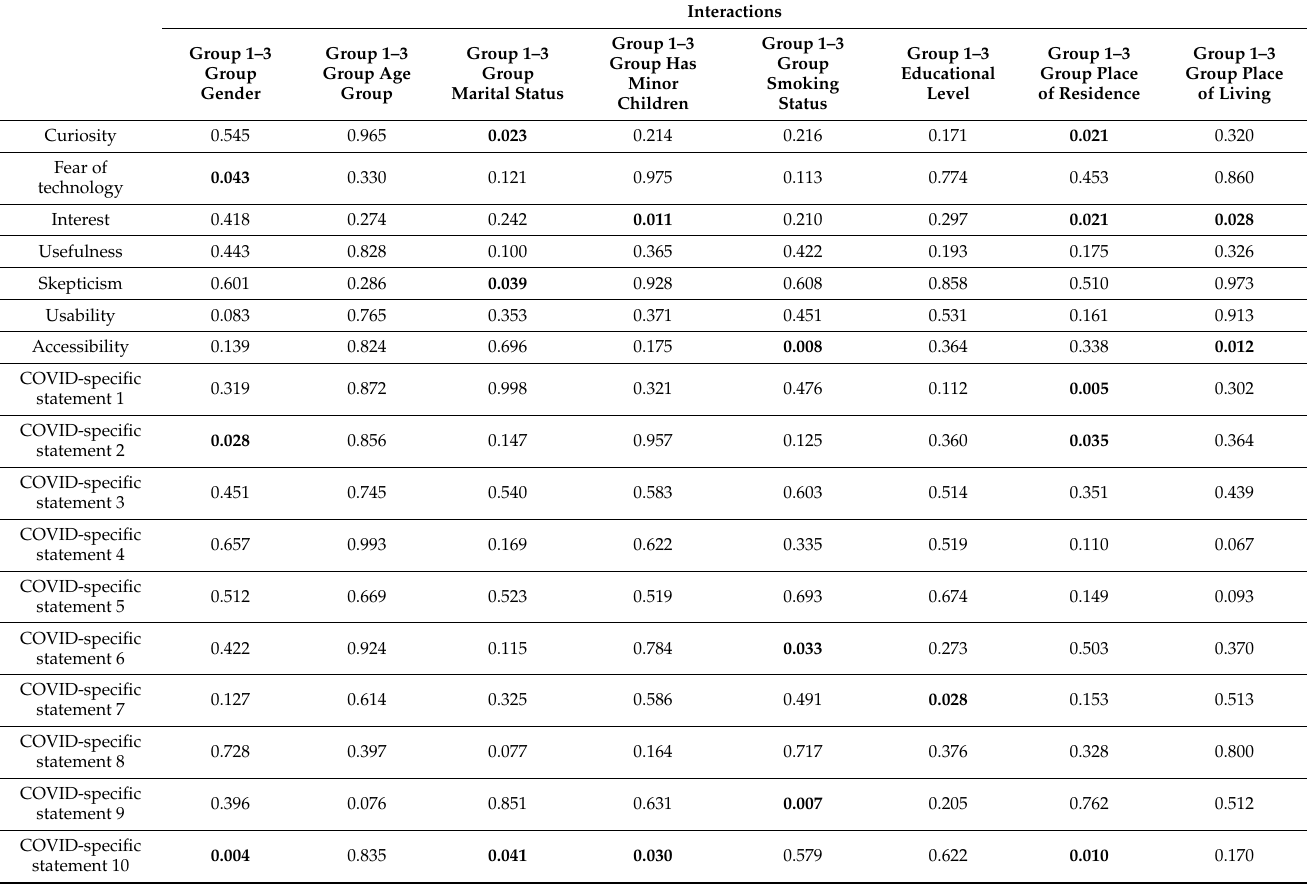
Table A1. p -values of interactions between Group 1 (COVID), Group 2 (Recovered), and Group 3 (Healthy) and sociode- mographic indicators for all dependent variables. ANOVA comparing Groups 1–3 to the different scales of the TUI